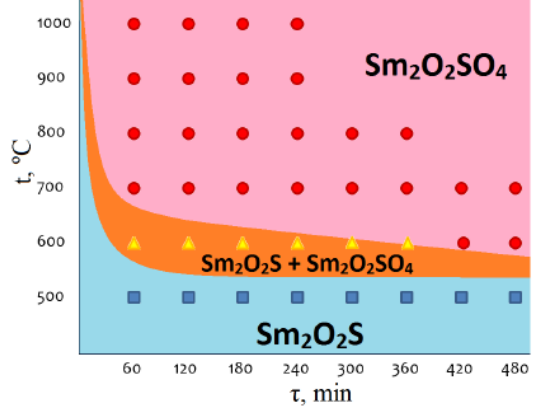
Figure 4. Kinetic scheme of changes in the chemical composition during the samarium oxysulfide oxidation.